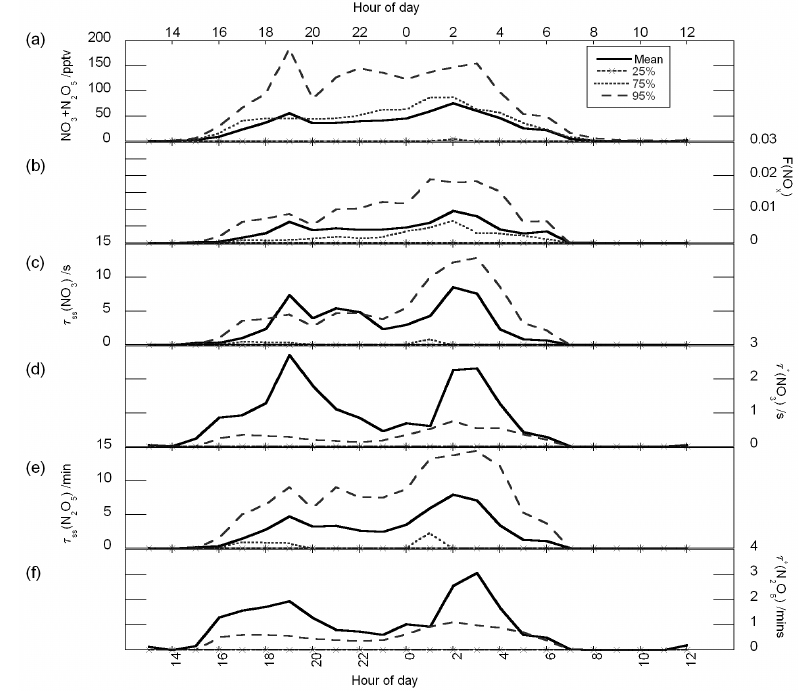
Fig. 10. Hourly average diurnal trend plots and their statistical ranges for (a) NO 3 +N 2 O 5 mixing ratios; (b) F (NO x ) ; (c) τ ss *(NO 3 )min and (d) non steady-state τ *(NO 3 )/s; (e) τ ss *(N 2 O 5 )/s (f) non steady-state τ *(N 2 O 5 )/min; for derivations of these values, see text. The large variability in both datasets is shown, as the mean being greater than the 95th percentile for much the non-steady-state treatment data. A shorter and more highly variable lifetime is determined by the non-steady state